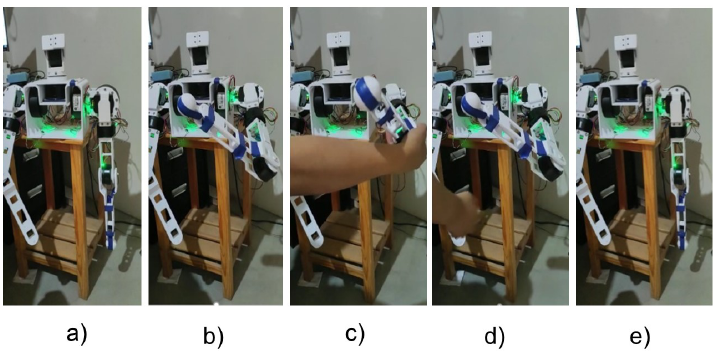
Figure 23. Frame of Left Arm positioned at [ − 59 ◦ ; 18 ◦ ; 61 ◦ ; 97 ◦ ]. ( a ) ZERO position; ( b ) Desired